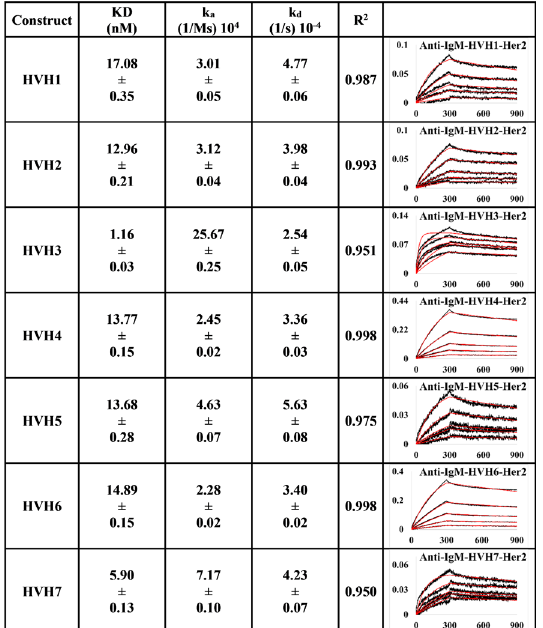
Figure 6. BLI measurement of trastuzumab IgM variants (HVH1-7) interacting with Her2 using PpL biosensor to capture the light chain of IgM KD, k , k , and R 2 , and fitting curves are shown according to the 1:1 model. PR indicates poor responses a d where measurements with a poor R 2 value are shown in red. The x-axis and y-axis of the graph represent time (s) and response (nM), respectively. All values are rounded off to 2 decimal places. Triplicate experiments were performed, and standard errors were